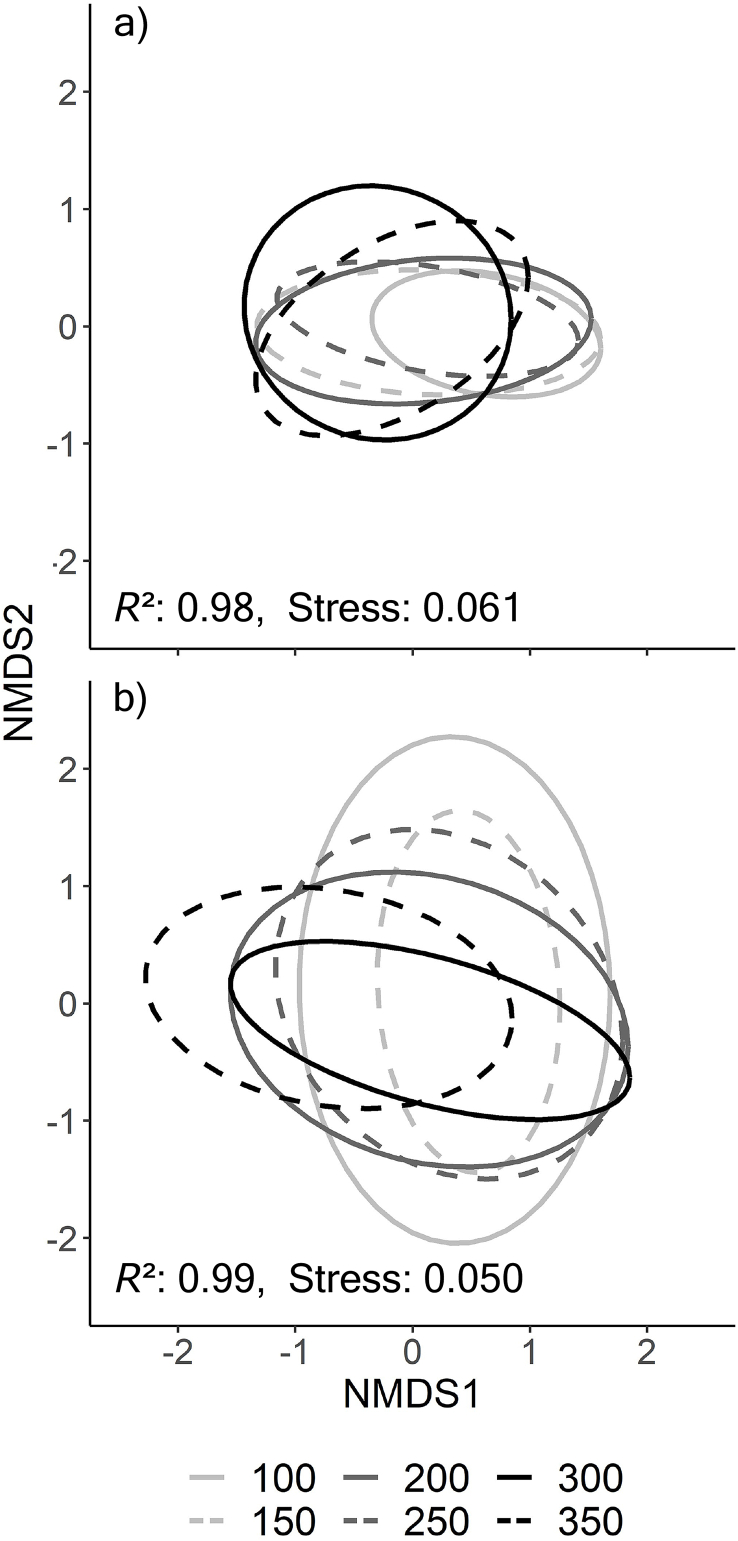
Nonmetric multidimensional scaling (NMDS) plot on Bray-Curtis distances of a) Arctic charr and b) brown trout showing dissimilarity in parasite community composition between different size classes including 95% confidence intervals ellipses. NMDS converged on a three-dimensional solution with an acceptable stress level.